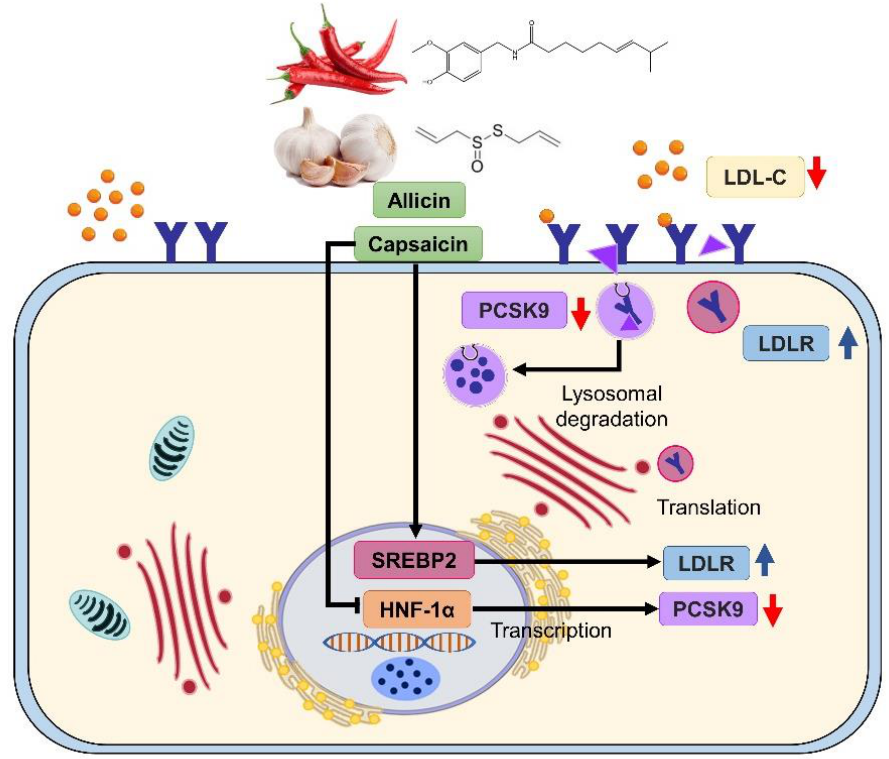
Figure 7. The proposed mechanism of allicin and capsaicin on the hypolipidemic effect in HepG2 cells.